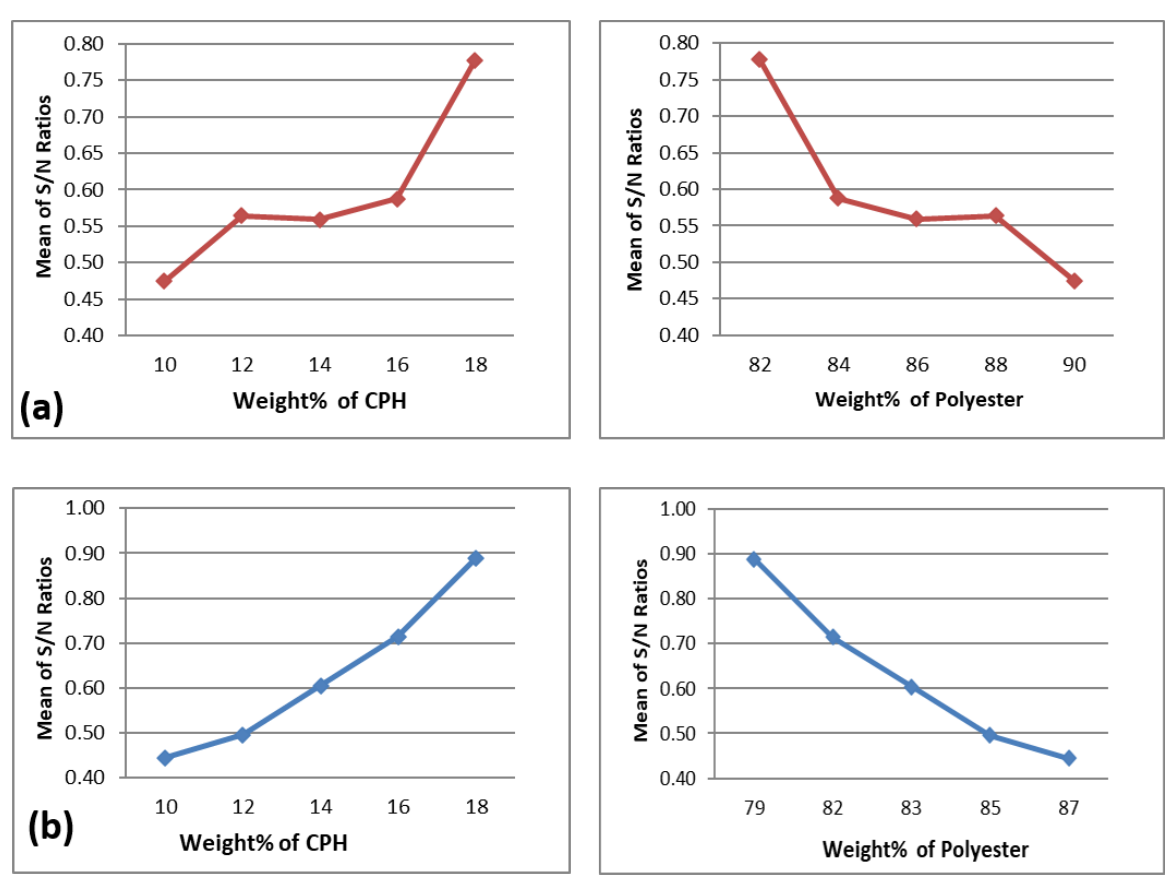
Figure 6. Main effect plot of optimal level conditions of factors for ( a ) mono-reinforced composite ( b ) hybrid composite.